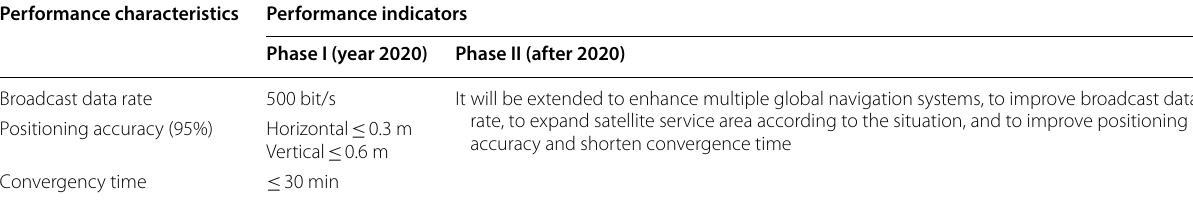
Table 2 Main BDS PPP Service Performance Indicators Performance characteristics